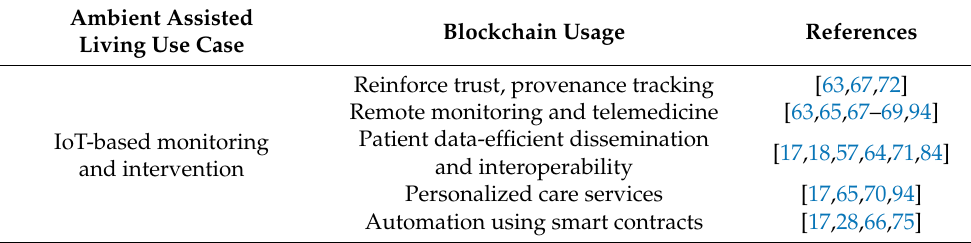
Table 3. Blockchain usage benefits of IoT monitoring in AAL